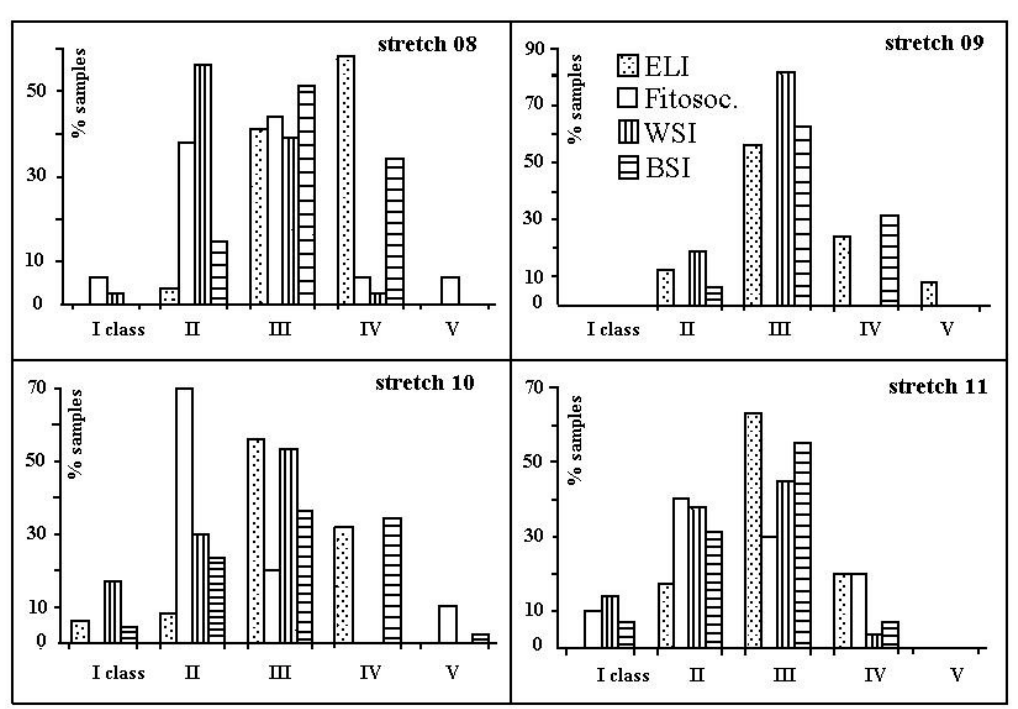
FIGURE 5. Trends of percentage of the riparian areas, riparian vegetation, and banks wild state (cid:150) buffer quality class.